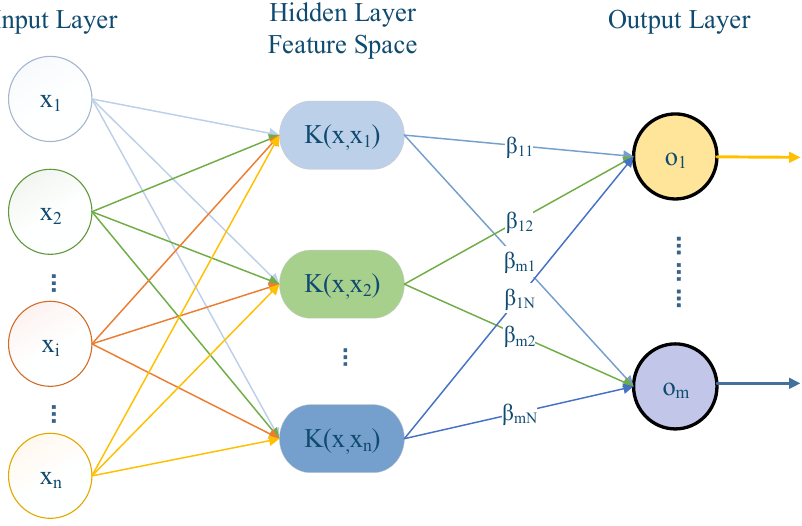
Figure 2. The structure diagram of the KELM model.